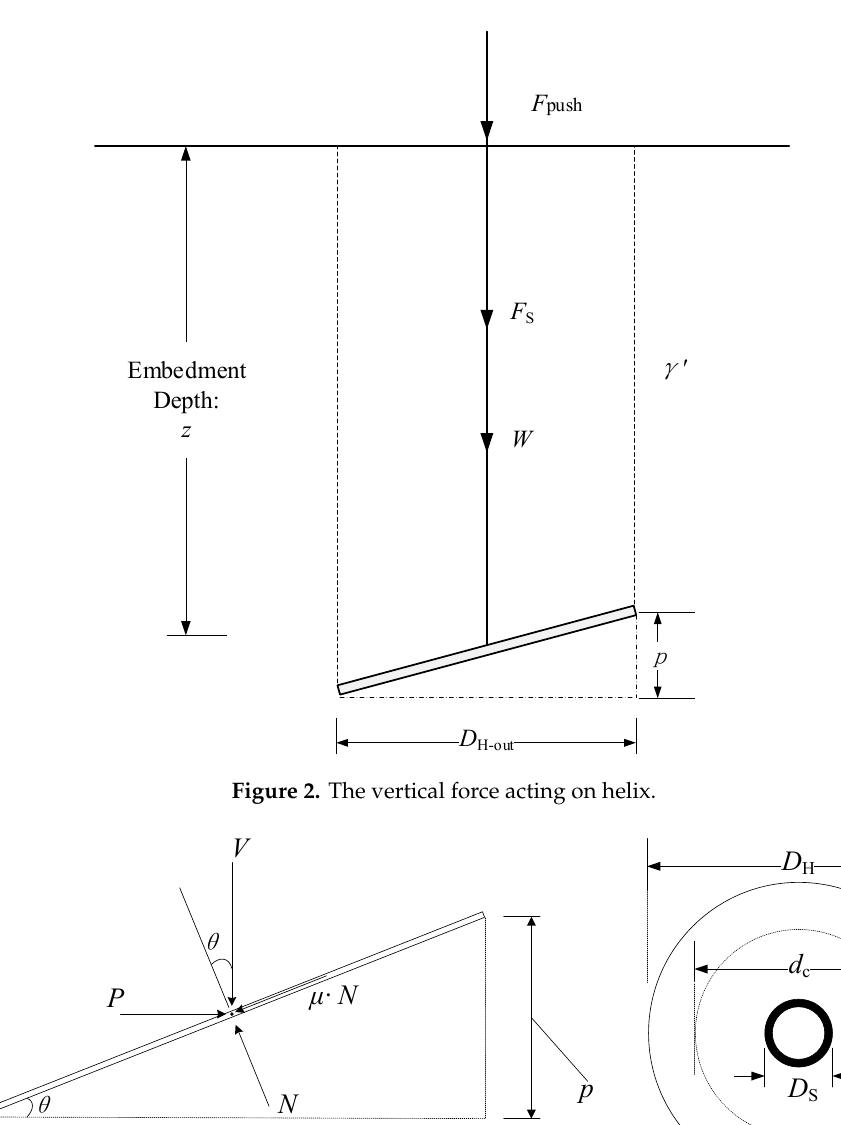
Figure 3. The force analysis and physical parameters of helix.